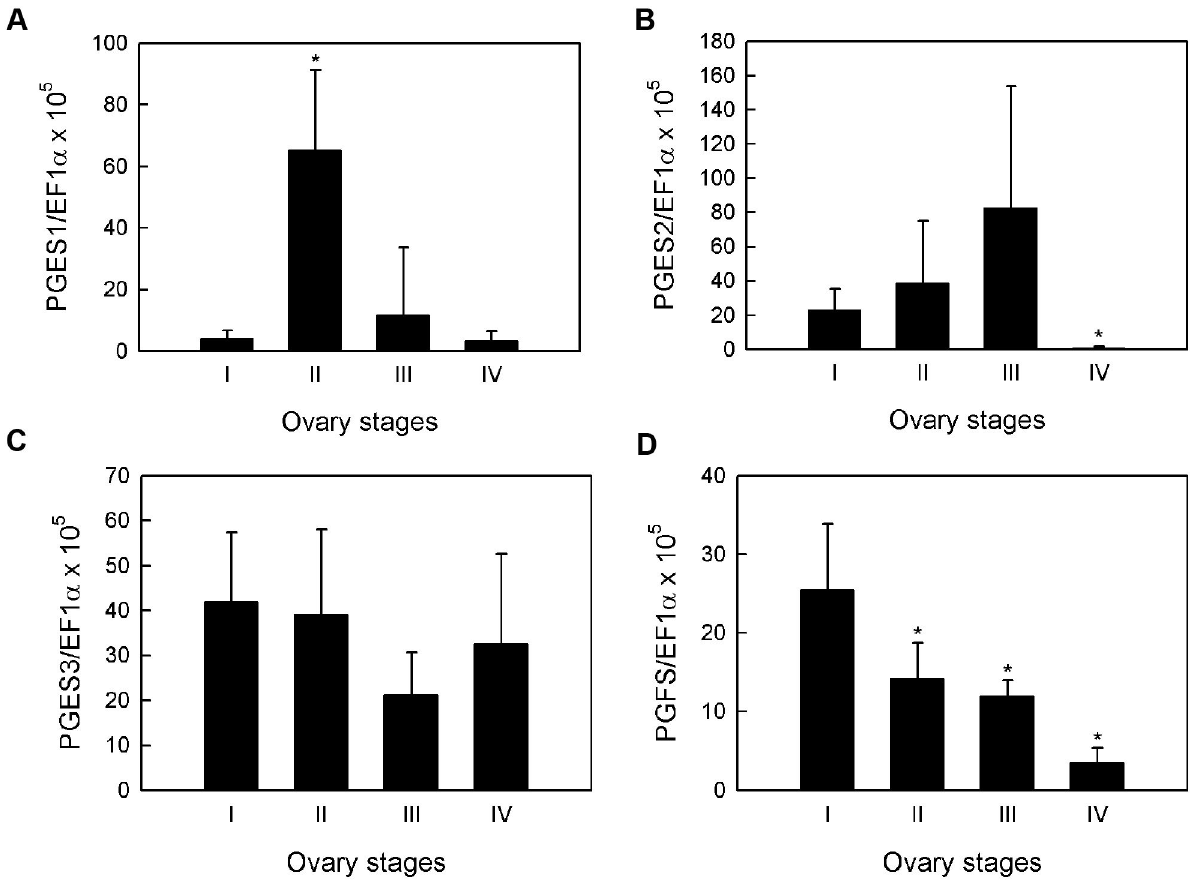
Figure 8. Relative expression levels of PmPGES and PmPGFS genes in each ovary stage. Wild broodstock from the Andaman Sea (N=27) were captured and dissected to obtain ovary samples used in the real-time PCR analysis. Each graph represents the average copy number of prostaglandin biosynthesis gene transcripts normalized against EF1α in each ovary stage. (A) PmPGES1 , (B) PmPGES2 , (C) PmPGES3 and (D) PmPGFS . Error bars show standard deviations and asterisks indicate significant changes between stages (p <